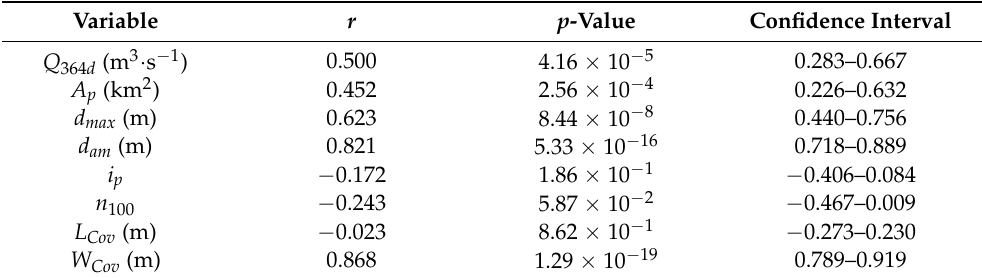
Table 2. The correlation coefficient ( r ) between variable AWS Cov and the stream characteristics, p -value, and confidence interval.